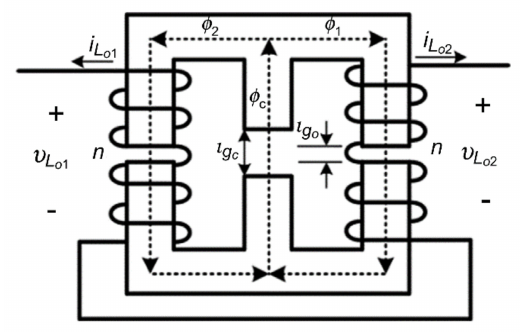
Figure 6. Coupled